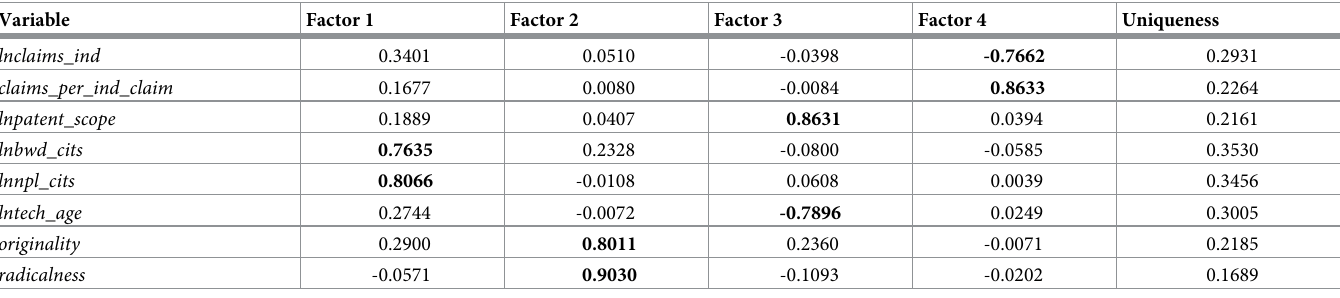
Table 4. Rotated factor loadings (pattern matrix) and unique